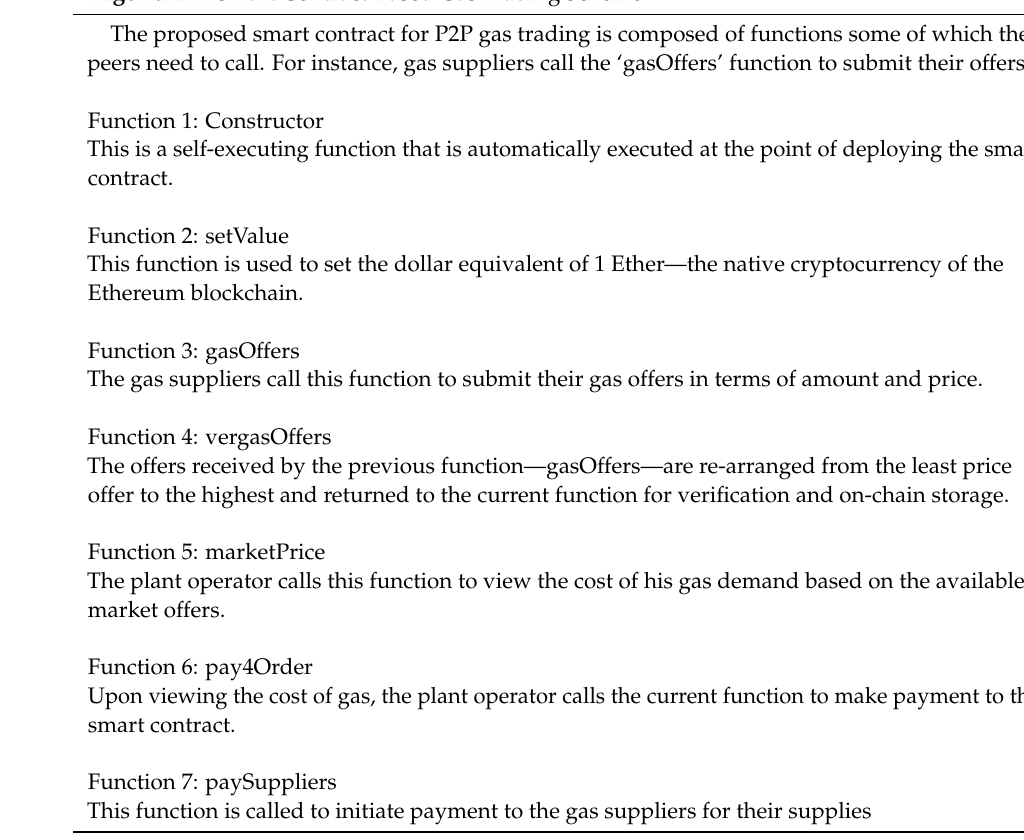
Algorithm 1 Smart Contract-Based Gas Trading Scheme.